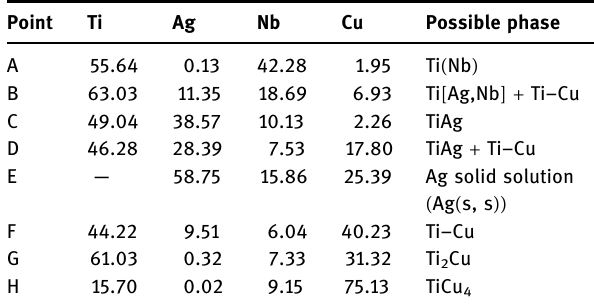
Table 2: Results of EDS at di ff erent positions shown in Figure 4 ( at% ) Point